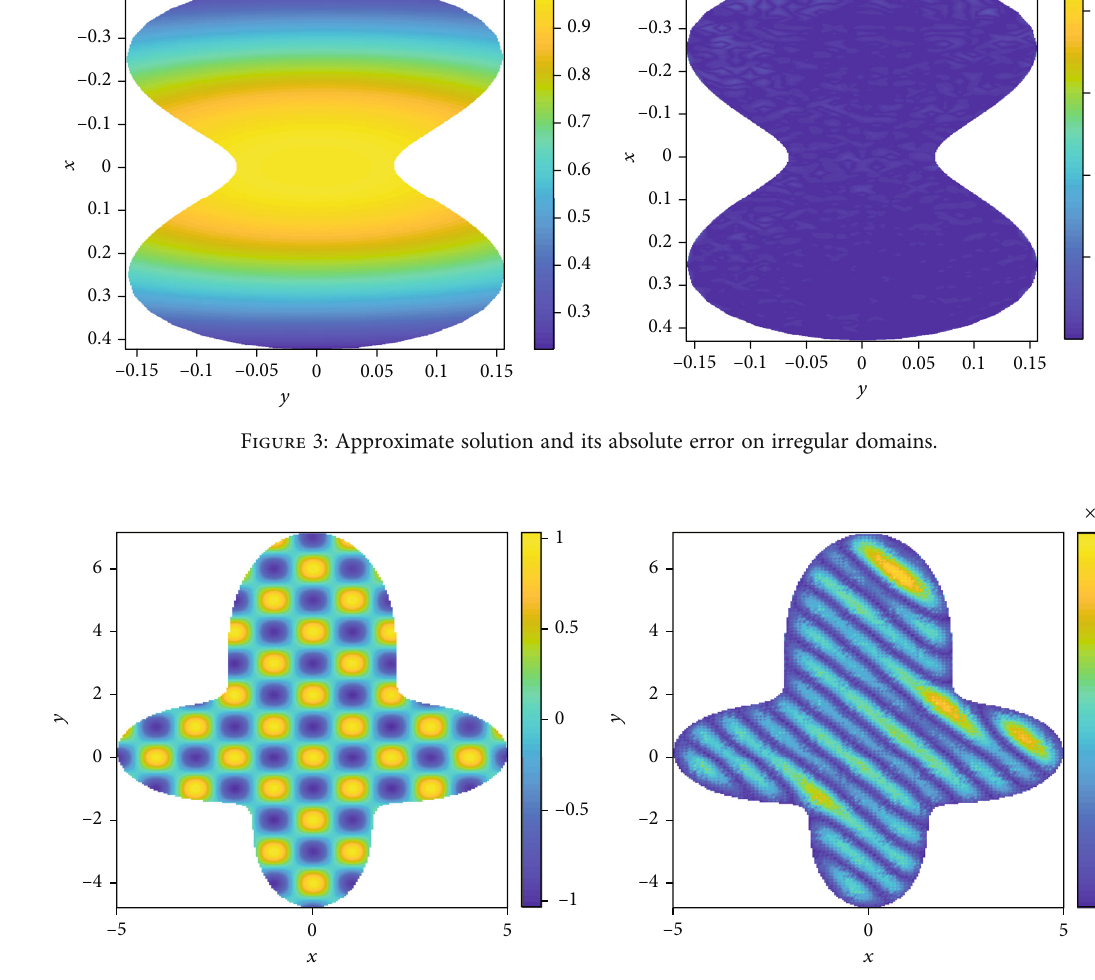
Figure 4: Approximate solution and its absolute error on irregular